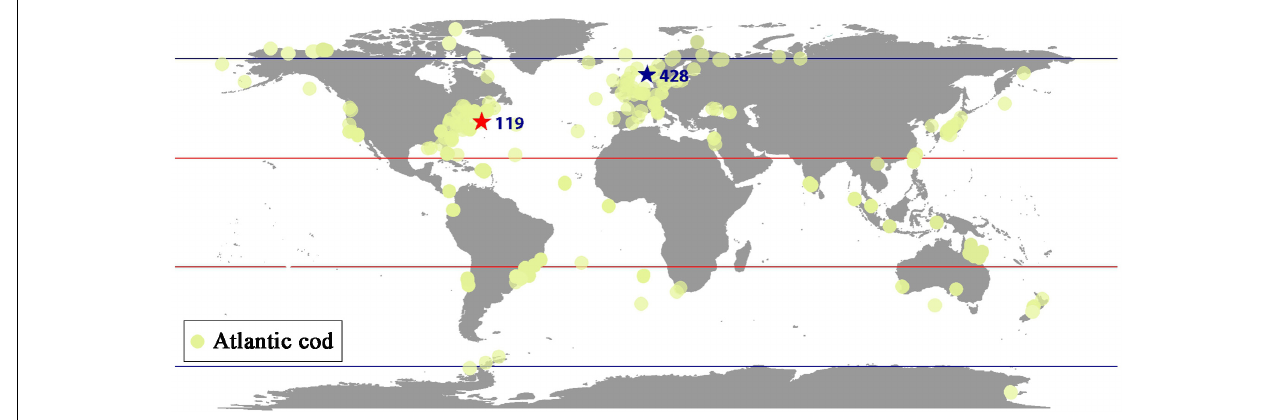
FIGURE 1 | Global distribution of Atlantic cod.